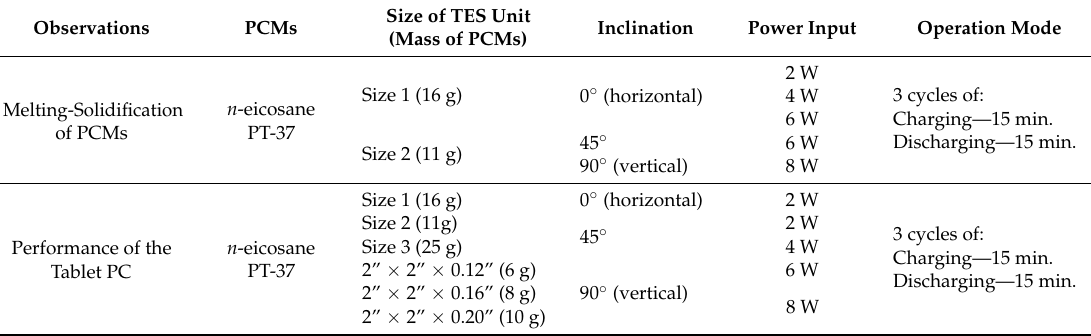
Table 3. Summary of experiments done in the intermittent